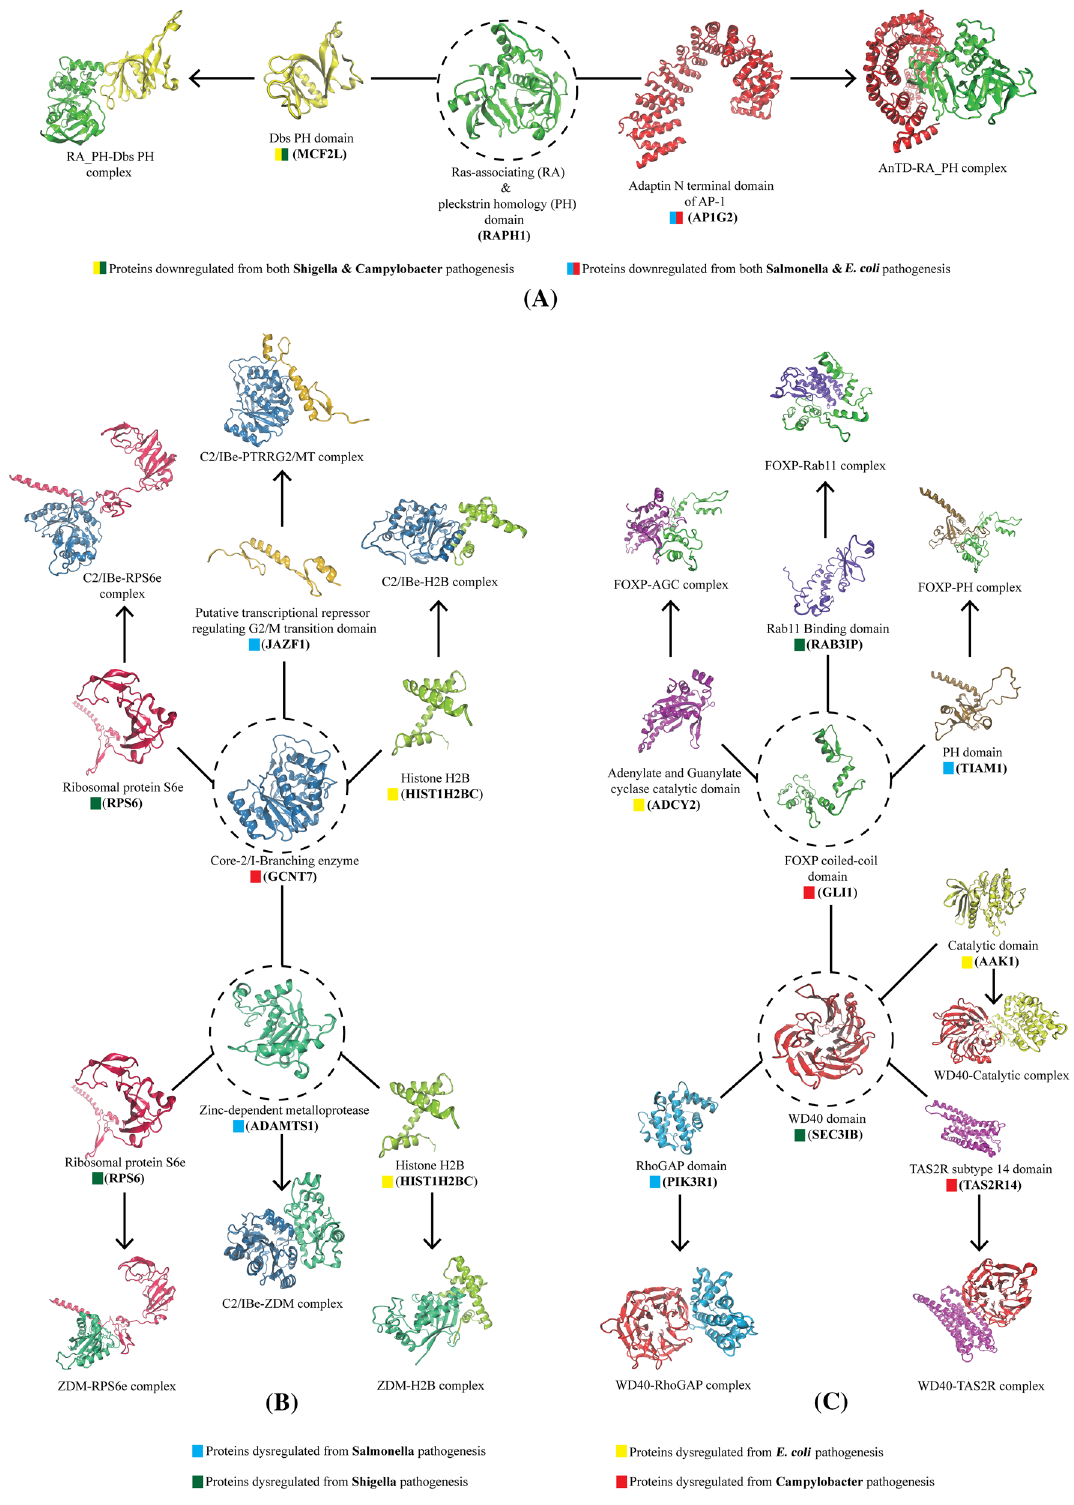
Figure 6. The 5 potential drug targets (shown in dotted circle) for single therapy. These 5 proteins have stable interaction with other proteins resulting from dysregulation by the pathogenesis of any of the four bacteria. The figure showing ( A ) the first drug target, RAPH1, which has stable interaction with MCF2L and AP1G2 proteins that downregulates from Shigella - Campylobacter and Salmonella - Campylobacter pathogenesis, respectively. ( B ) The second group of drug targets, GCNT7, and ADAMTS1, which upregulates from E. coli and Salmonella infections, had stable interaction with HIST1H2BC and RPS6 proteins that upregulates from Shigella and Campylobacter infection. GCNT7 was also found to be stable with ADAMTS1 and JAZF1, which are the upregulated hub proteins resulting from Salmonella pathogenesis. ( C ) The third group of drug targets, GLI1 and SEC31B, downregulates from E. coli and Campylobacter infection. GLI1 showed a stable association with ADCY2, RAB3IP, TIAM1, and SEC31B that downregulates from Shigella , Salmonella, and Campylobacter, respectively, while SEC31B had stability with PIK3R1, AAK1, and TAS2R14 downregulating from Salmonella , Shigella, and E. coli